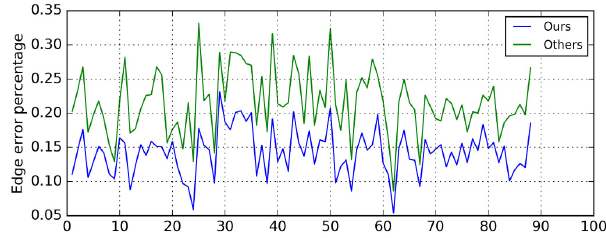
Fig. 11 Edge errors for our algorithm and the method in Ref. [21].